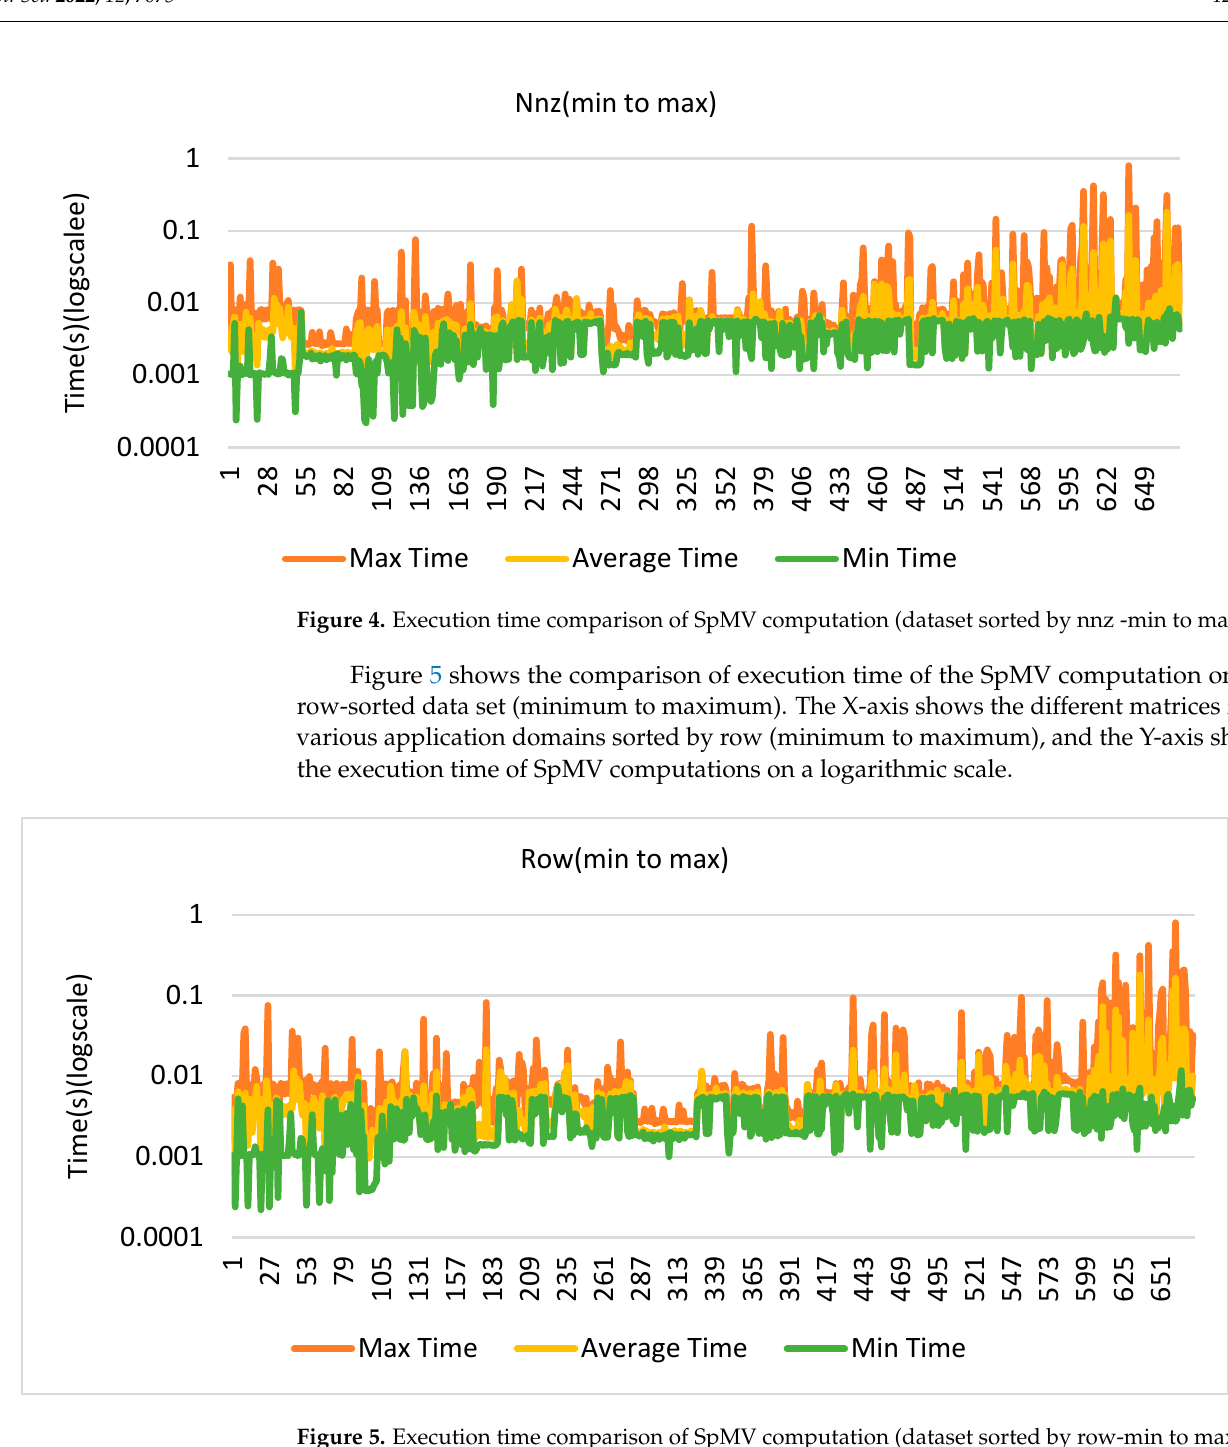
Figure 6. Execution time comparison of CSR and BCSR (with and without format conversion time). 4.3. Speedup Figures 7 and 8 show the speed up of the entire dataset sorted on rows and the number of non-zeros, respectively. The speedup average and speedup maximum are calculated using Equations (9) and (10), respectively. The X-axis shows the number of matrices in our entire data set, and the Y-axis shows speedup against the average and worst-case scenarios.